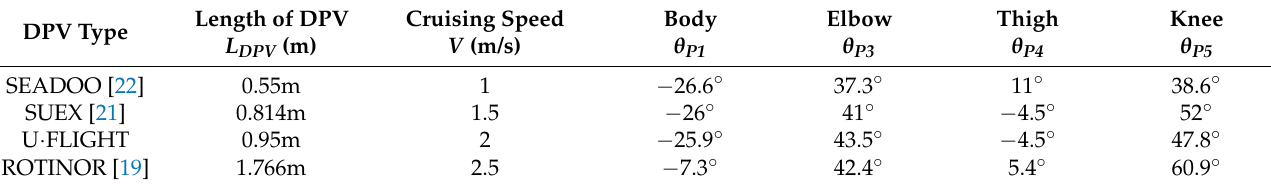
Figure 7. Driving posture of four typical DPV [19,21,22]. Table 2. Parameters of four typical DPV